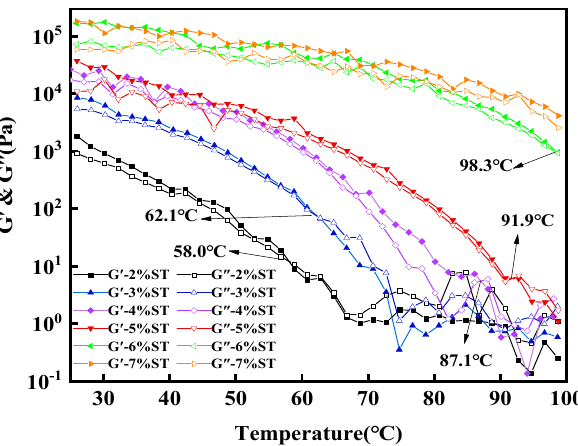
Figure 5. Different stigmasterol concentrations (2–7%) of stigmasterol organogels had viscoelastic properties in the temperature range of 25 to 100 °C.